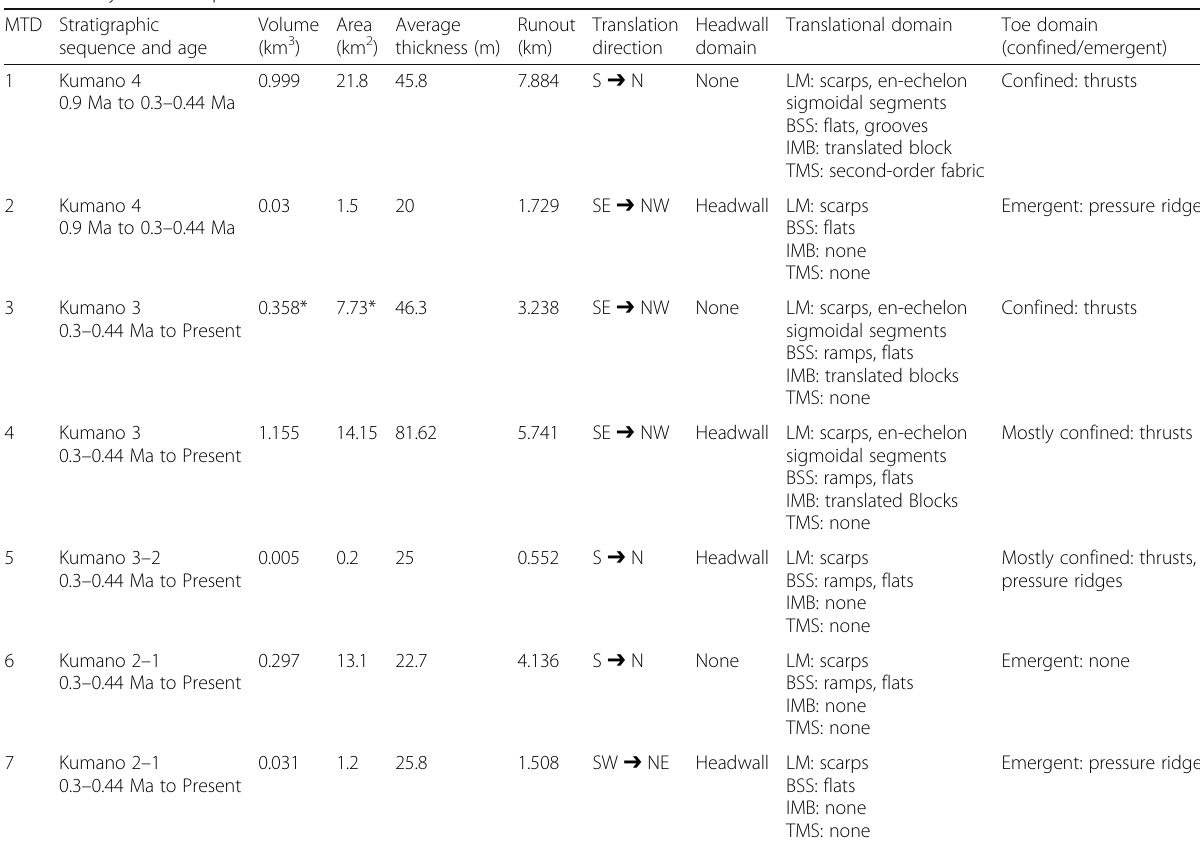
Table 1 Physical MTD parameters and identified kinematic indicators MTD Stratigraphic sequence and